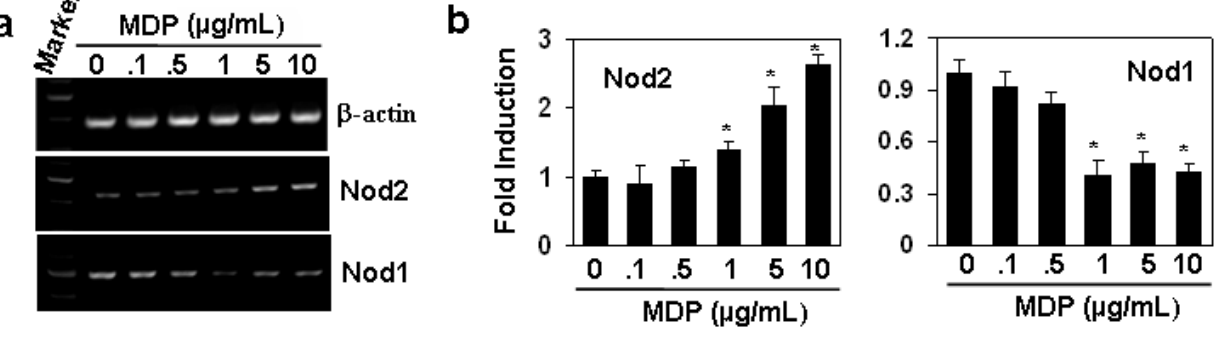
Figure 2. The effect of MDP on the gene expression of NOD1 and NOD2 . ( a ) HAECs were treated with indicated concentrations of MDP for 24 h. The gene expression of NOD1 and NOD2 was measured by RT-PCR. β -actin gene expression was measured as loading control; ( b ) The quantitation of NOD1 and NOD2 gene expression in ( a ) by qRT-PCR. * P < 0.05 compared with the control groups, n = 3 in each